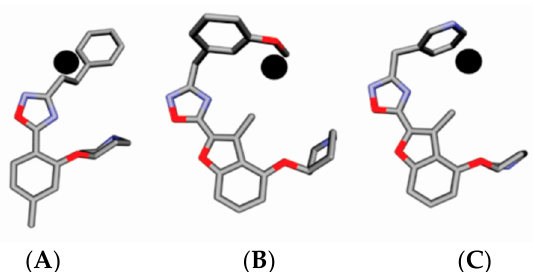
Figure 4. Representation of GCOD-2 ( − 1, − 4, − 4, np) (black sphere) and ( A ) compound 42 , ( B ) compound 81 , and ( C ) compound 83 . CODs occupancy represented by black spheres to decrease the potency of the compounds. The gray and red representations are carbons and oxygen atoms.